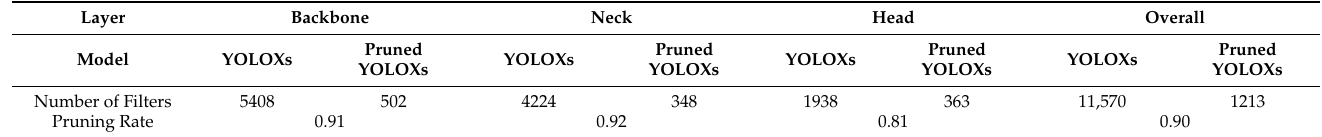
Table 1. Change in filters before and after